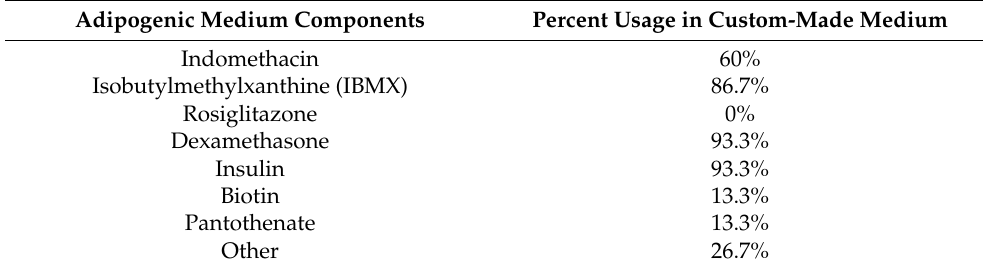
Table 2. Adipogenic medium components used in custom-made media. Results reported as the percentage of papers that used a given adipogenic medium component.